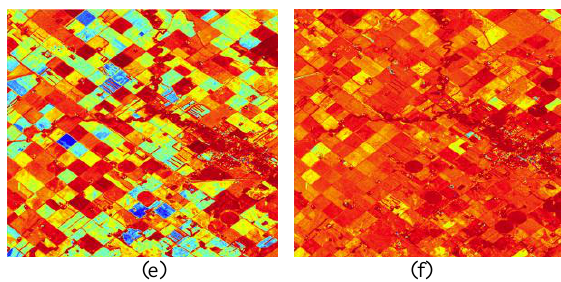
Figure 5. H-A-α decomposition parameters, (a,b) alpha, (c,d) anisotropy and (e,f) entropy for Jun and July respectively. The results of difference kernel in c-means clustering based change detection with H-A-α stack images are showed in Fig 6. The stack image is used to consider all parameters of H-A-α decomposition in change detection approach.